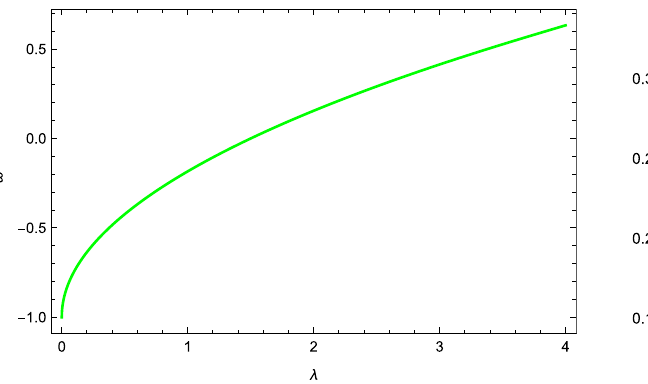
Fig. 6 Plot of Hubble parameter( H ) versus ( λ )